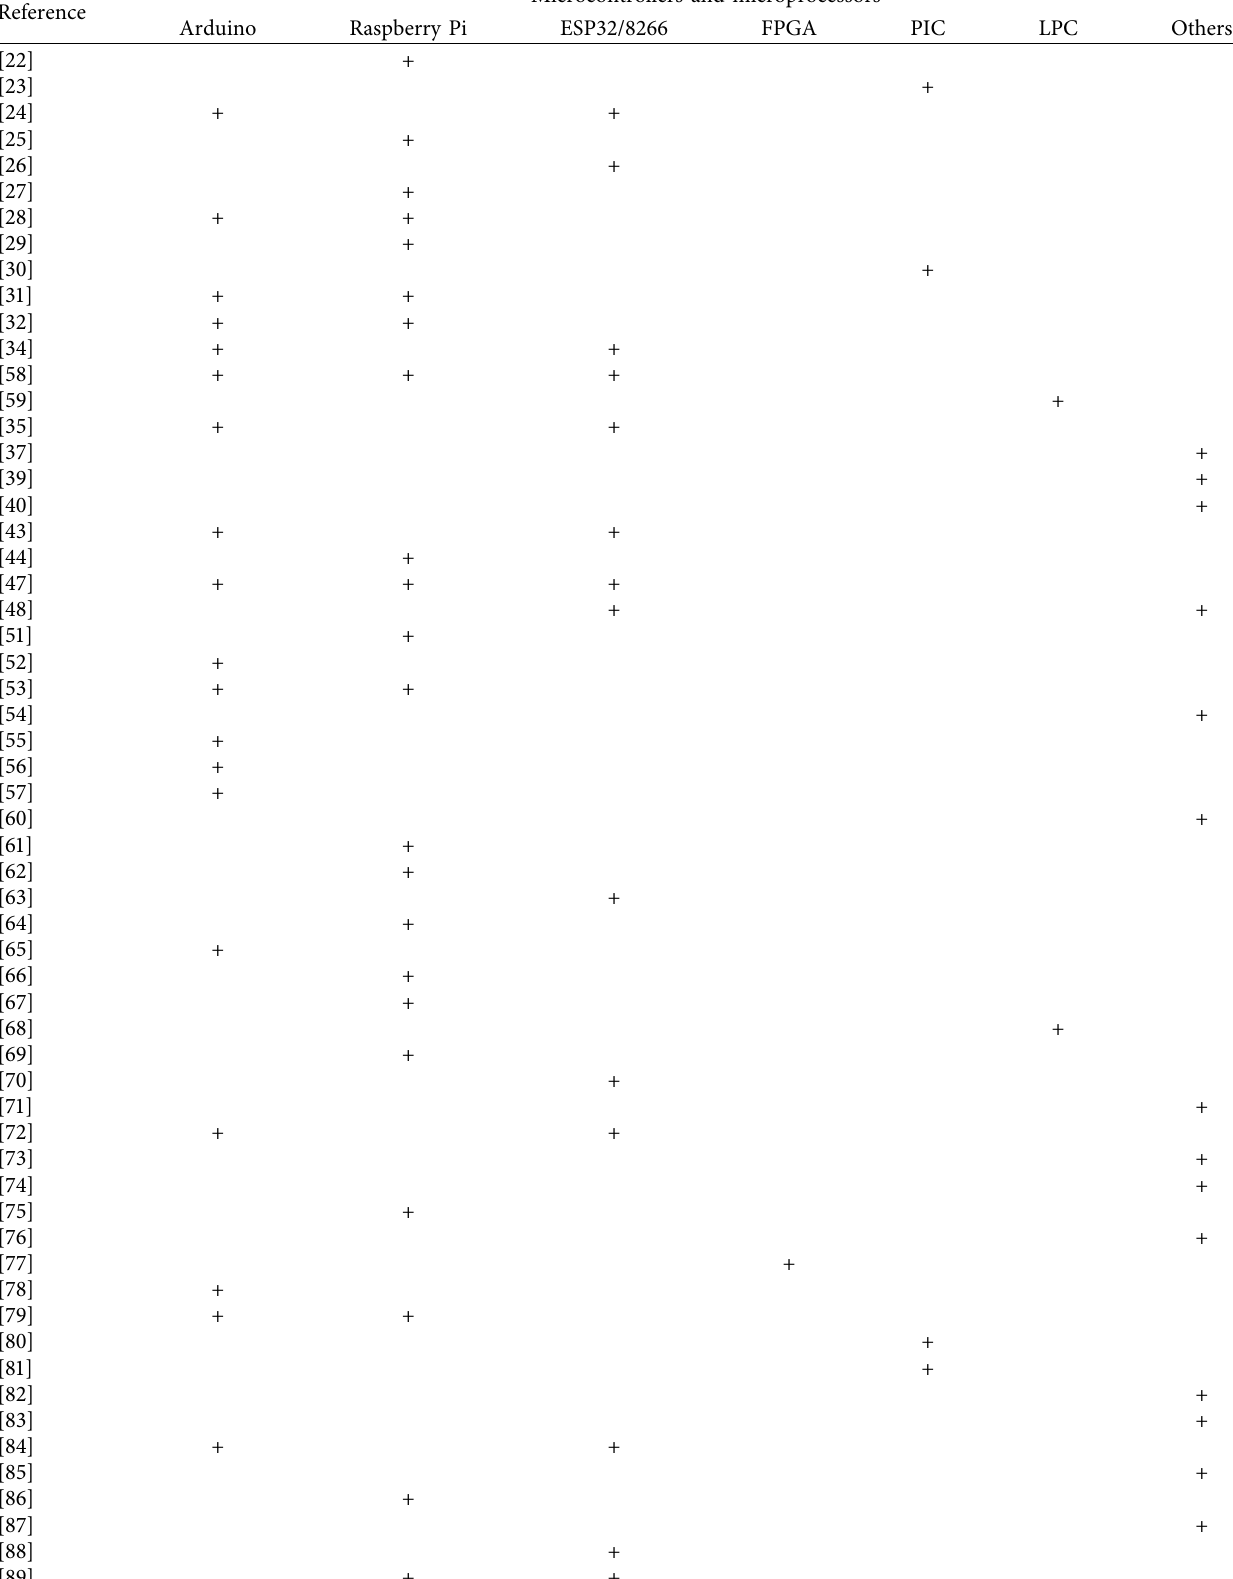
Table 3: Classifcation of SHSs according to microcontroller and microprocessor